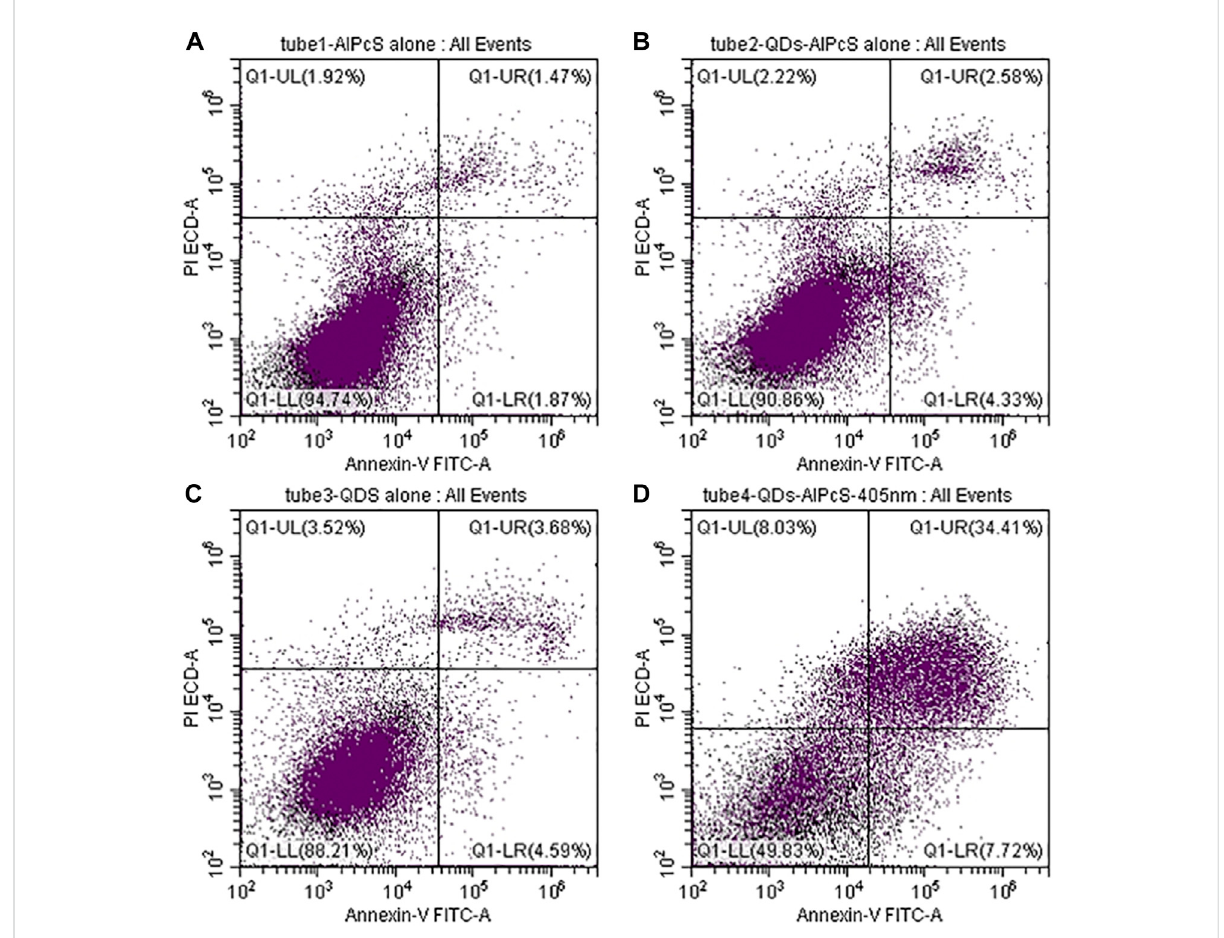
FIGURE 7 Cell death induction by QDs – AlPcS solution combined with 405 nm excitation in A375 cells. Q1-UL: necrotic cells (Annexin V negative/PI positive) Q1-UR: late apoptotic cells (Annexin V positive/PI positive) Q1-LL: viable cells (Annexin V negative/PI negative) Q1-LR: early apoptotic cells (Annexin-V positive/PI negative). (A) Cell viability of A375 cells incubated in free AlPcS (20 uM) solution without irradiation. (B) Cell viability of A375 cells incubated in QDs – AlPcS (0.4 uM – 20 uM) solution without irradiation. (C) Cell viability of A375 cells incubated in free QDs (0.4 uM) solution without irradiation. (D) Cell viability of A375 cells incubated in QDs – AlPcS (0.4 uM – 20 uM) solution with 405 nm